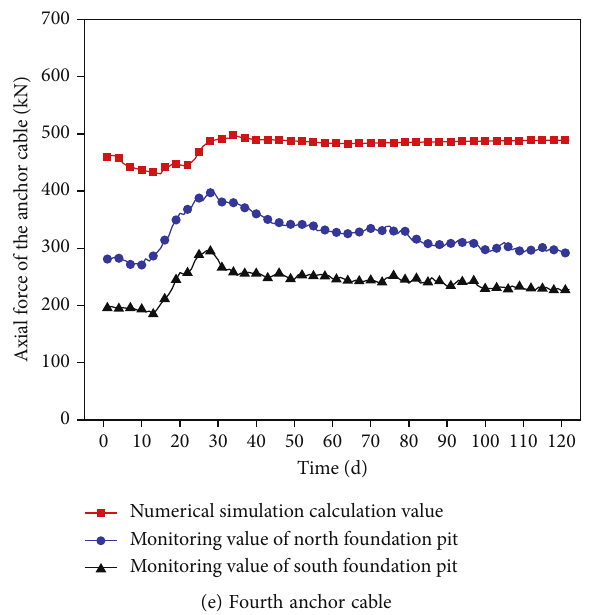
Figure 6: Comparison between simulation and monitoring results about the axial force of the anchor cables.